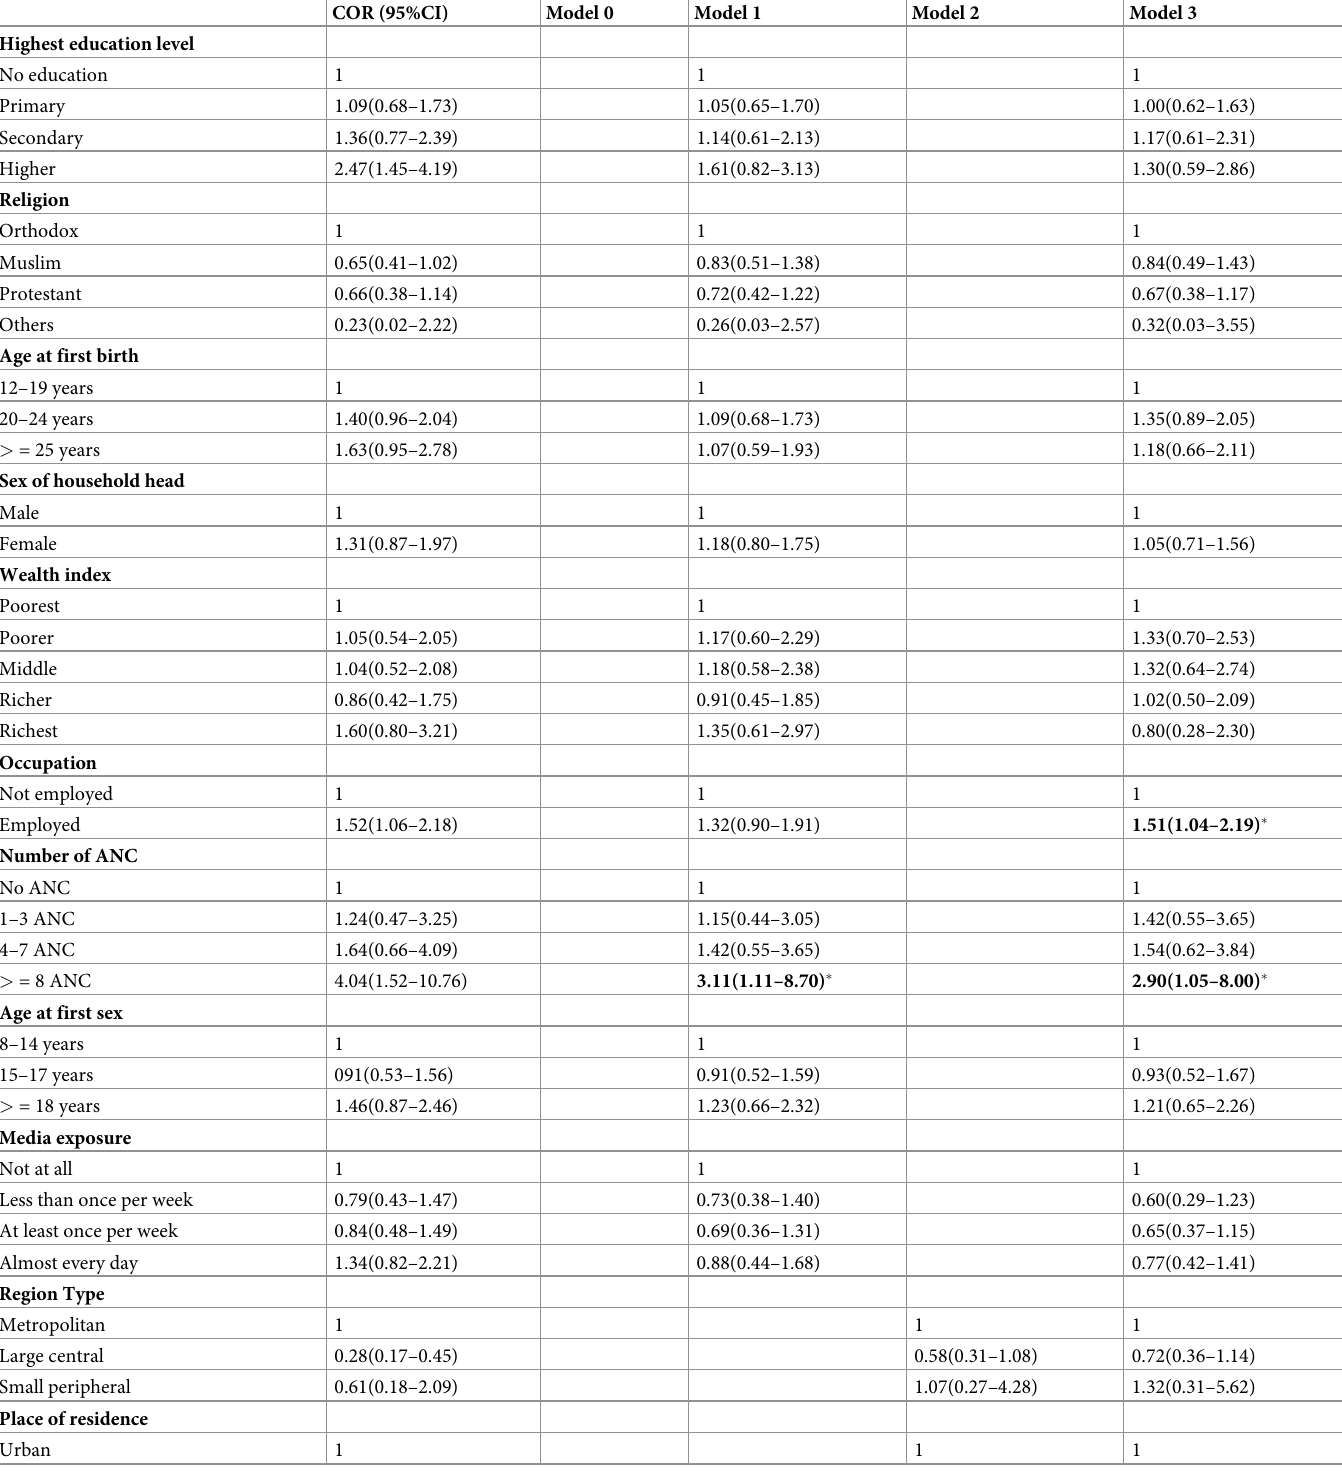
Table 3. Multilevel logistic regression analysis for factors associated with returning to health facility for postnatal care utilization among mothers who delivered in health facility in Ethiopia: Analysis of the 2016 EDHS. Individual and community level